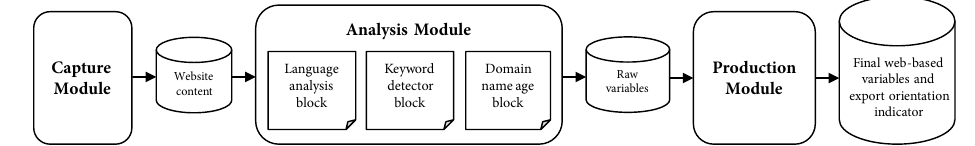
Capture Fig. 1. Model for a web data mining system to retrieve the web-based variables